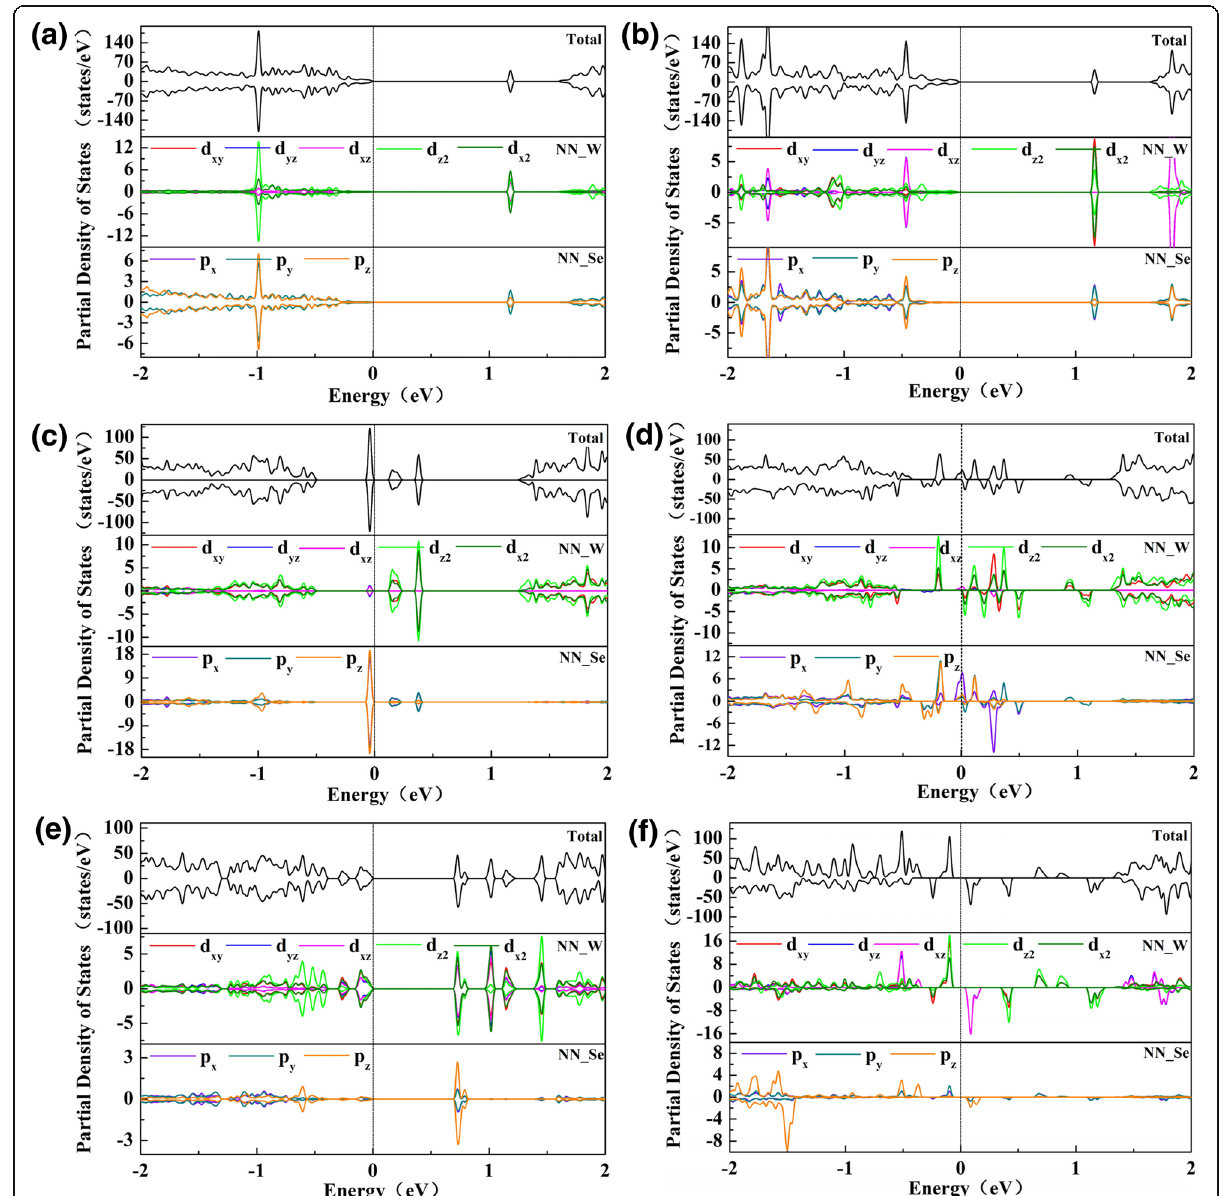
Fig. 4 The partial density of states (PDOS) of monolayer WSe 2 with a V Se , b V Se-Se , c V W , d V W2 , e V WSe3 , and f V WSe6 vacancies. NN_W and NN_Se represent the nearest neighboring W and Se atoms around the vacancy, respectively. Fermi level is set as 0